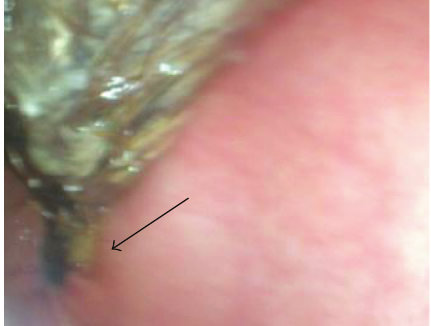
Figure 2: Endoscopy demonstrating trichobezoar extending through pylorus (arrow).